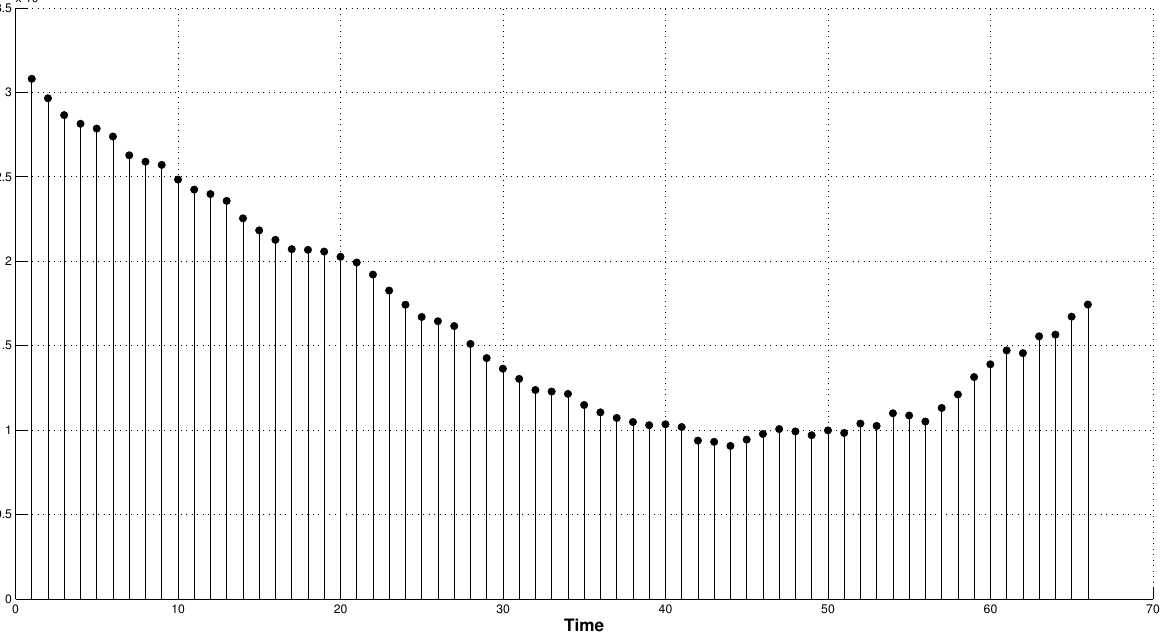
Figure 2. The number of active infections in Germany in the period 26 April to 30 May 2022